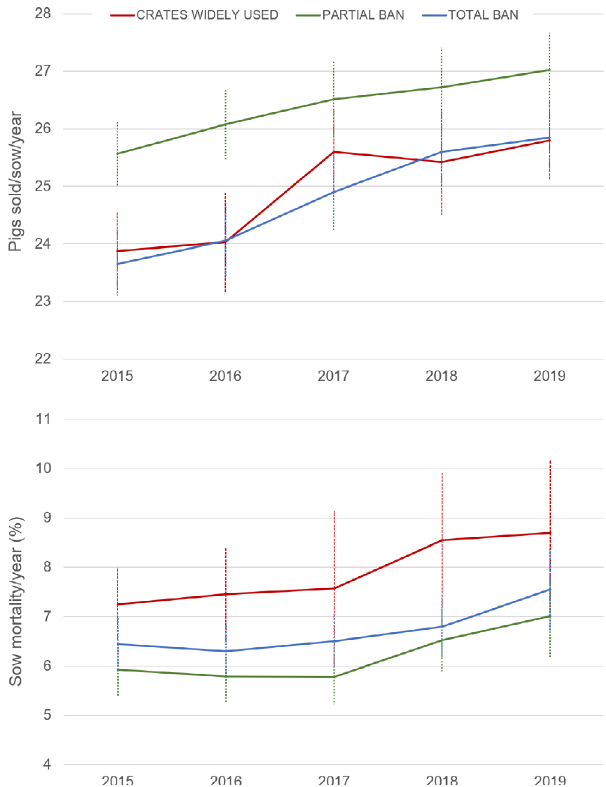
Figure 2. Average sow mortality (% year) and pigs sold/sow/year in three housing systems. Data from 17 countries belonging to the InterPig network, divided in three groups: (1) countries where gestation crates are the norm (Red: USA, Canada, Brazil), (2) gestation crates are restricted to (up to) the first four weeks of pregnancy (Black: Austria, Belgium, Czech Republic, Denmark, Finland, France, Germany, Hungary, Ireland, Italy, Netherlands, Spain), and (3) gestation crates are entirely banned (Blue: Sweden, United Kingdom (UK)). In the UK, data up to 2018 reflects a blend of indoor and free-range systems, and in 2019 indoor systems only.